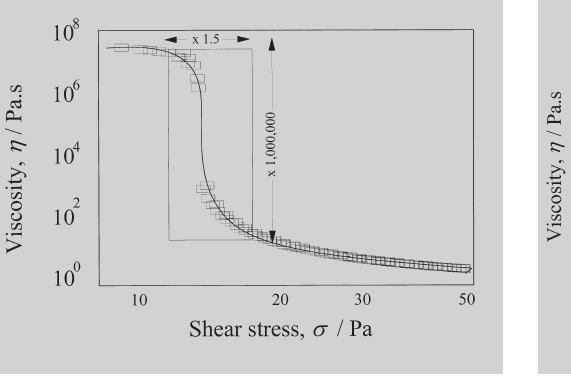
Figure 1 (left): Flow curve of molten chocolate measured in a vane geometry to eliminate slip. Figure 2 (right): Flow curves for various concentrations of Carbopol 980 in water, each showing a million-fold drop in viscos- ity for a three-fold increase in shear stress.